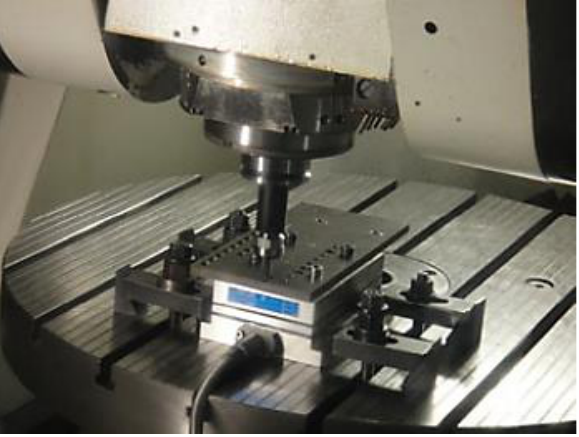
Figure 12. Experimental setup for measuring the cutting forces in helical milling [121]. Reproduced with permission from Springer.